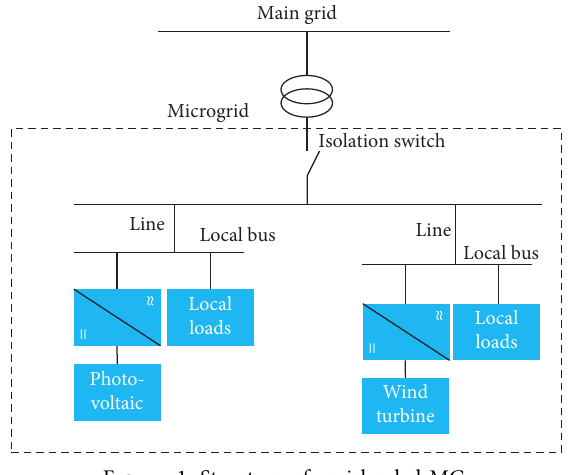
Figure 1: Structure of an islanded